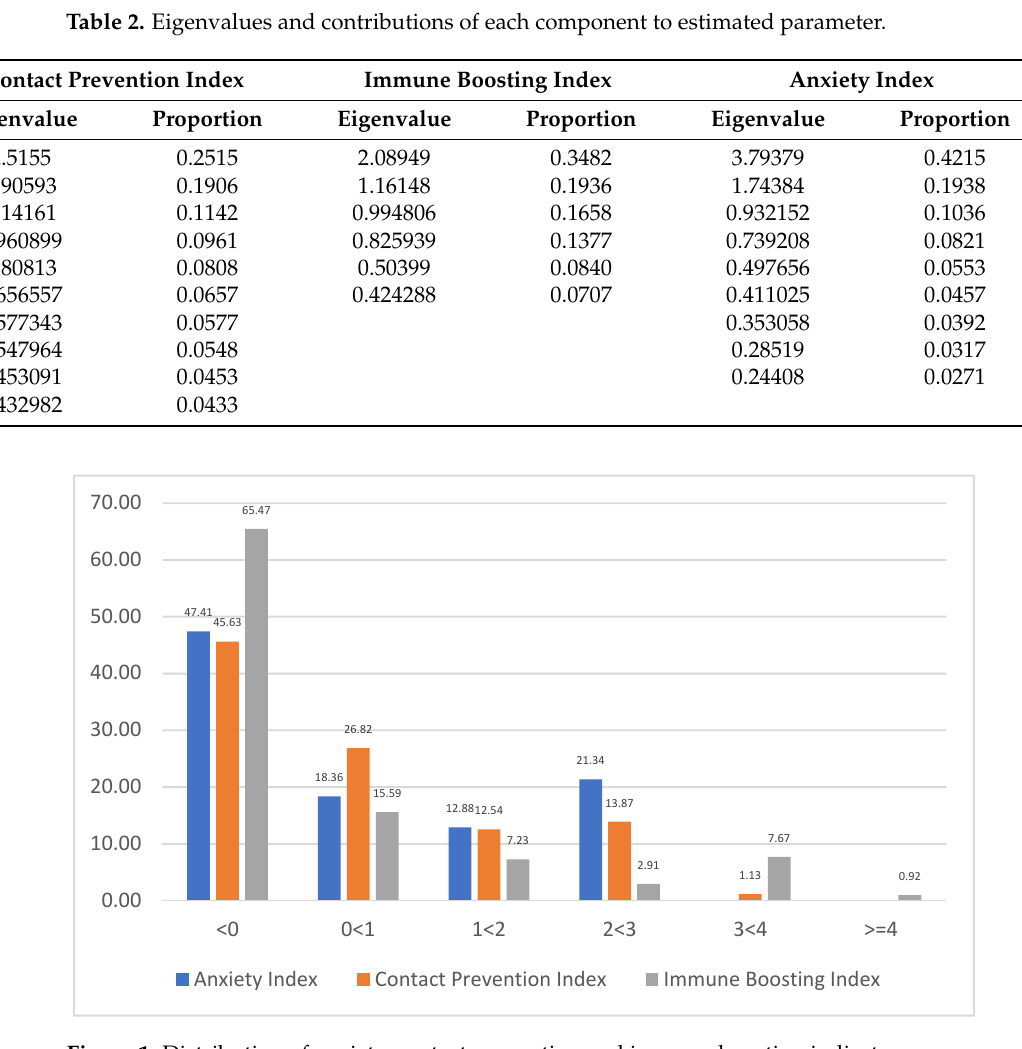
Figure 1. Distribution of anxiety, contact prevention and immune boosting indicators.